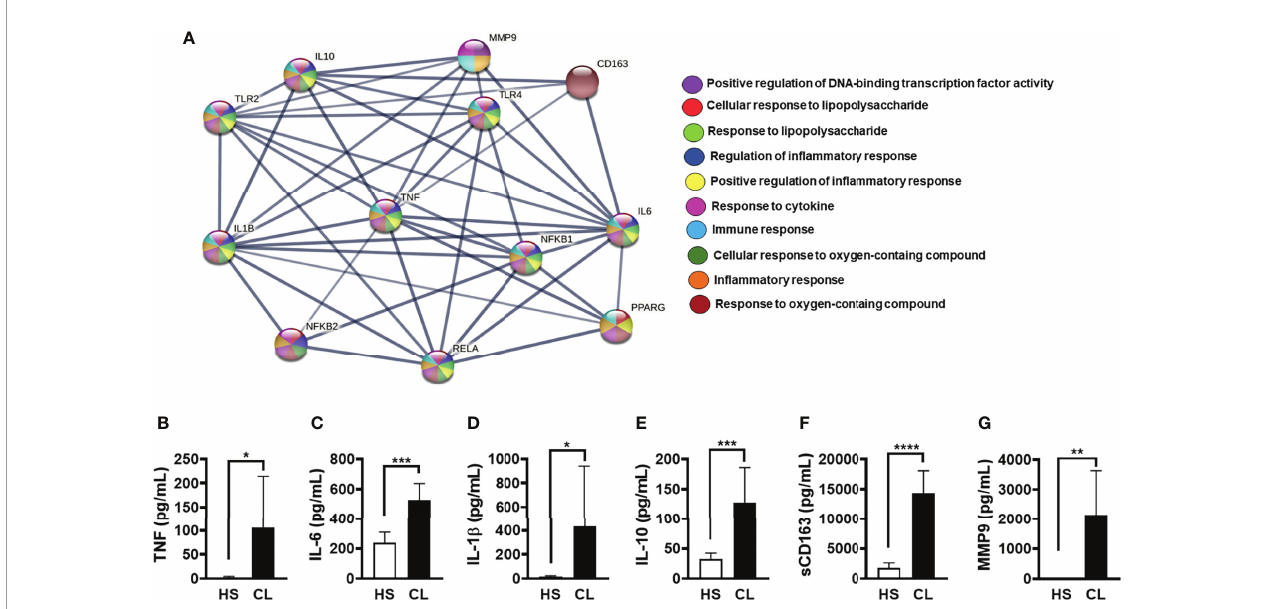
FIGURE 1 | STRING protein – protein interaction (PPI) network. (A) Enrichment analysis of the Gene Ontology (GO) and pathways revealed that a group of in fl ammatory proteins that participate in the pathogenesis of cutaneous leishmaniasis (CL) (IL-1 b , IL-6, TNF, NF k B1, and RELA) were directly linked to the peroxisome proliferator-activated receptor- g (PPAR- g ) protein. The lines show the interaction between the proteins and their thickness and the level of interaction between them. The analysis shows the enrichment value PPI (p ≤ 1.0 – 16). Biopsies from CL patients (n = 10) and healthy subjects (HSs) (n = 5) were obtained with a 4-mm punch and cultured for 24 h. The levels of (B) TNF, (C) IL-6, (D) IL-1 b , (E) sCD163 (F) MMP9, and (G) sCD163 were quanti fi ed by the ELISA technique. The box represents the mean, and the line above the box is the SD. Statistical analyses were performed using the paired t-test. *p < 0.05, **p < 0.01, ***p < 0.001, and ****p <